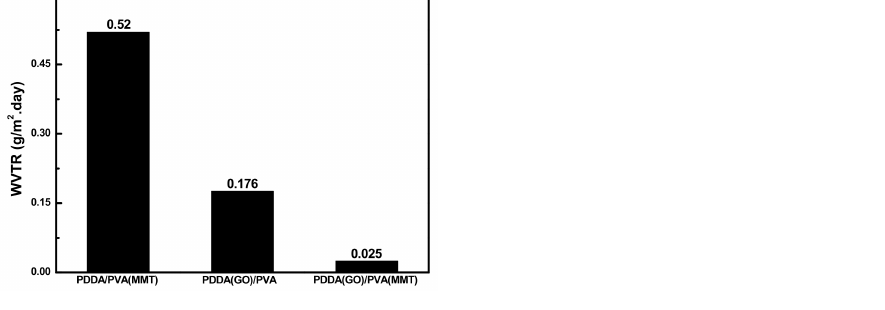
Figure 7. WVTR results of PDDA/PVA (MMT), PDDA (GO)/PVA, and PDDA (GO)/PVA (MMT) gas barrier films.